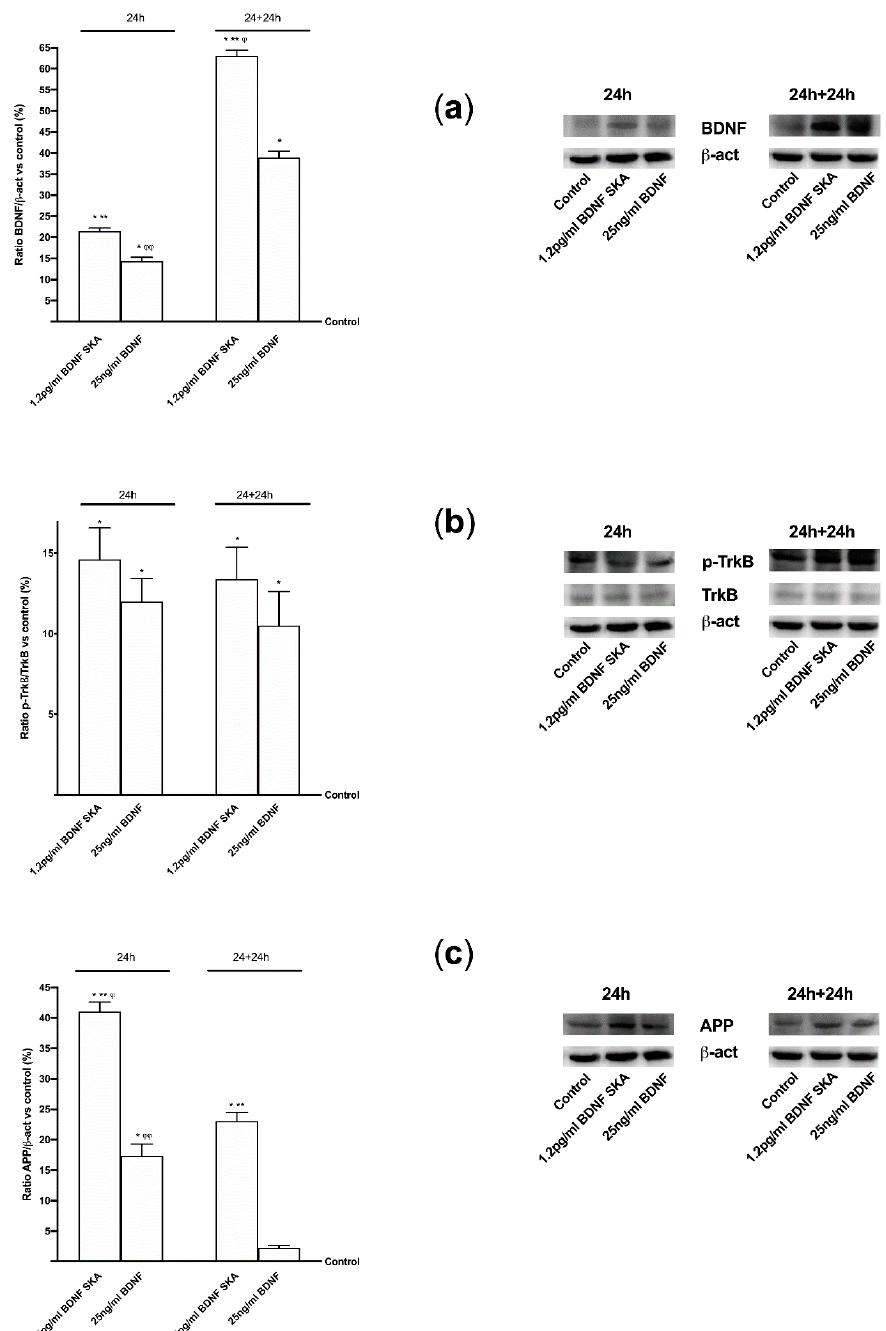
Figure 9. Western blot and densitometric analysis of BDNF protein ( a ), TrkB ( b ) receptor and ( c ) APP protein expressions in brain tissue. In the left column densitometric analysis and in the right the examples of Western blot are reported. Each graph contains on the left the results obtained at 24 h (12 animals) and on the right (12 animals) at 24 h plus 24 h (24 h+24 h). Data are expressed as means ± SD (%) of independent experiments normalized on specific total protein if possible and verified by β -actin detection. * p < 0.05 vs. control; ** p < 0.05 vs. 25 ng / mL BDNF at the same time of administration; ϕ p < 0.05 vs. 1.2 pg / mL BDNF SKA between 24 h and 24 h plus 24 h; ϕϕ p < 0.05 vs. 25 ng / mL BDNF between 24 h and 24 h plus 24